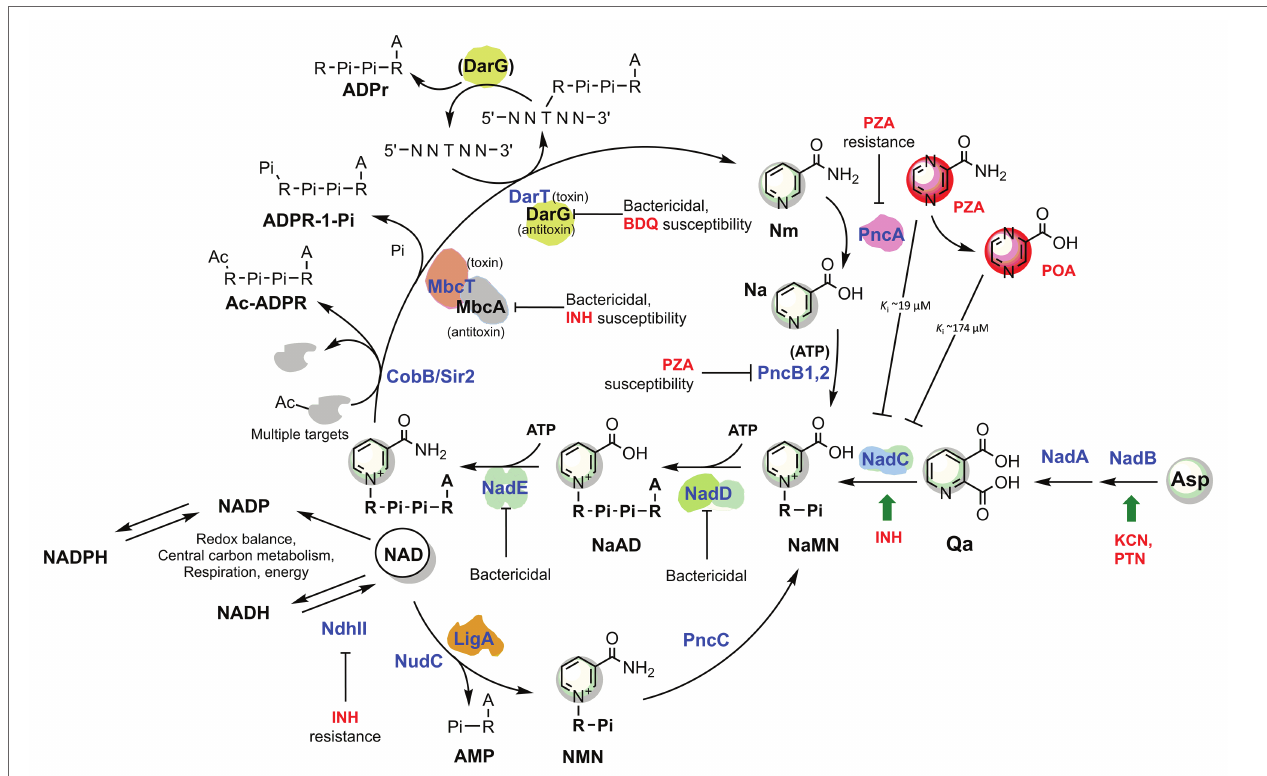
FIGURE 2 | The metabolic interplay between TB drugs and NAD pathways in Mycobacterium tuberculosis . Enzymes (blue) are identified with their gene name, metabolites’ names are in black, and TB drugs or inhibitors are in red. The effects of targeted enzymes’ inhibition/downregulation on bacterial growth or drug efficacy are shown. Green arrows indicate upregulated enzymes upon drug exposure, according to transcriptional analyses. Proteins with available 3D structures are sketched based on their biological quaternary assembly. Enzyme abbreviations: NadB (Rv1595): ASPOX, L-aspartate oxidase; NadA (Rv1594): QSYN, quinolinate synthetase; NadC (Rv1596): QaPRT, quinolinate phosphorybosyltransferase; PncB1 (Rv1330c): NaPRT1, nicotinate phosphoribosyltransferase; PncB2 (Rv0573c): NaPRT1, nicotinate phosphoribosyltransferase; NadD (Rv2421c): NaMNAT, NaMN adenylyltransferase; NadE (Rv2438c): NADS, glutamine-dependent NAD syntetase; PncA (Rv2043c): NMASE, nicotinamide deamidase; PncC (Rv1901): NMND, NMN deamidase; LigA (Rv3014c): NAD-dependent DNA ligase; NudC (Rv3199c): NAD(H) pyrophosphatase; NdhII (Rv1854c); type II NADH:menaquinone oxidoreductase; Sir2/CobB (Rv1151c): NAD-dependent deacetyltransferase. Metabolite abbreviations: NaAD, nicotinic acid adenine dinucleotide; Nam, nicotinamide; Na, nicotinic acid; Qa, quinolinic acid; NaMN, nicotinic acid mononucleotide; NMN, nicotinamide mononucleotide; PRPP, phosphoribosyl diphosphate; PZA, pyrazinamide; POA, pyrazinoic acid; BDQ, bedaquiline; INH, isoniazid; PTN, pretomanid; KCN, potassium